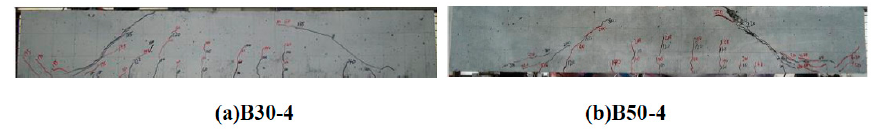
Figure 7. Typical failure mode of C30 and C50 grade concrete beams.